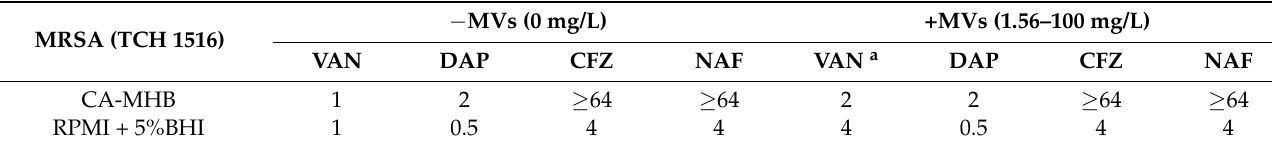
Data are represented as mg/L. a VAN MIC increased from 1 to 2 mg/L and 1 to 4 mg/L in the presence of MV concentrations ranging from 25–100 mg/L and 50–100 mg/L in CA-MHB and RPMI + 5%BHI, respectively. MRSA: Methicillin-Resistant Staphylococcus aureus ; MVs: Membrane Vesicles; MIC: Minimum Inhibitory Concentration; CA-MHB: Cation-adjusted Mueller–Hinton Broth; RPMI + 5%BHI: Roswell Park Memorial Institute 1640 + 5% Brain Heart Infusion; VAN: Vancomycin; DAP: Daptomycin; CFZ: Cefazolin; NAF: